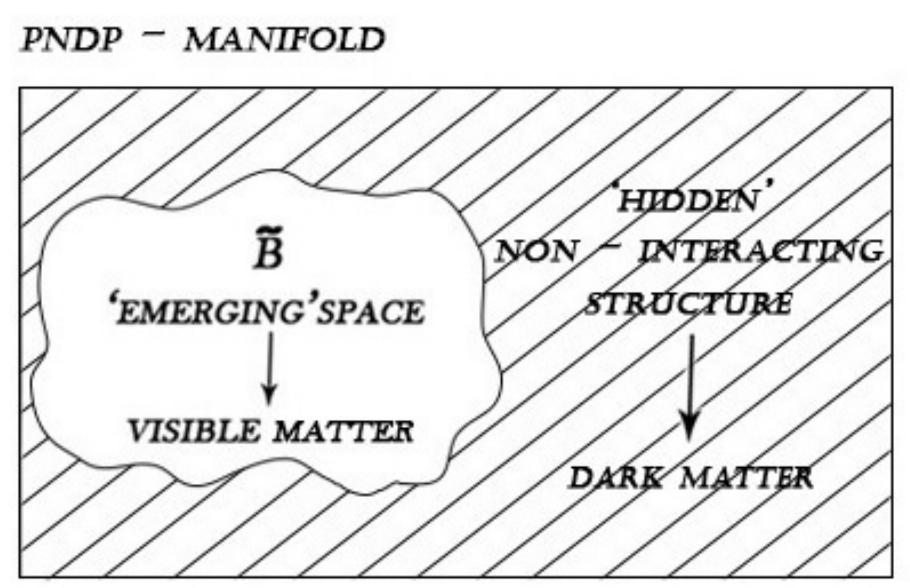
Figure 4. The image shows a PNDP-manifold, in which the emerging part is considered visible matter, while hidden part of the structure, which we considered non-interacting, represents dark